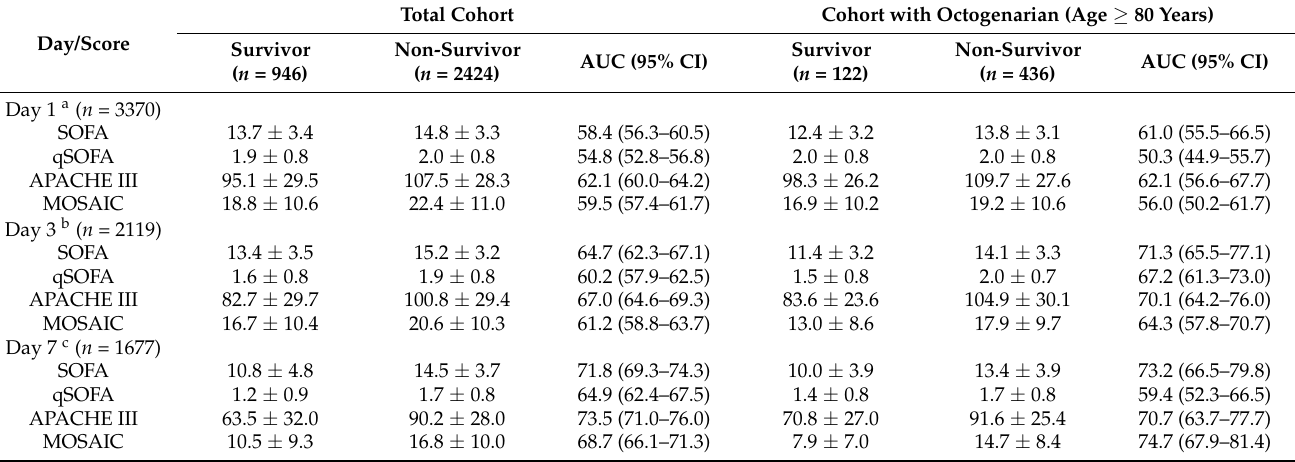
Table 4. Performance of the scoring systems in predicting in-hospital mortality in the entire cohort and in patients older than 80 years.